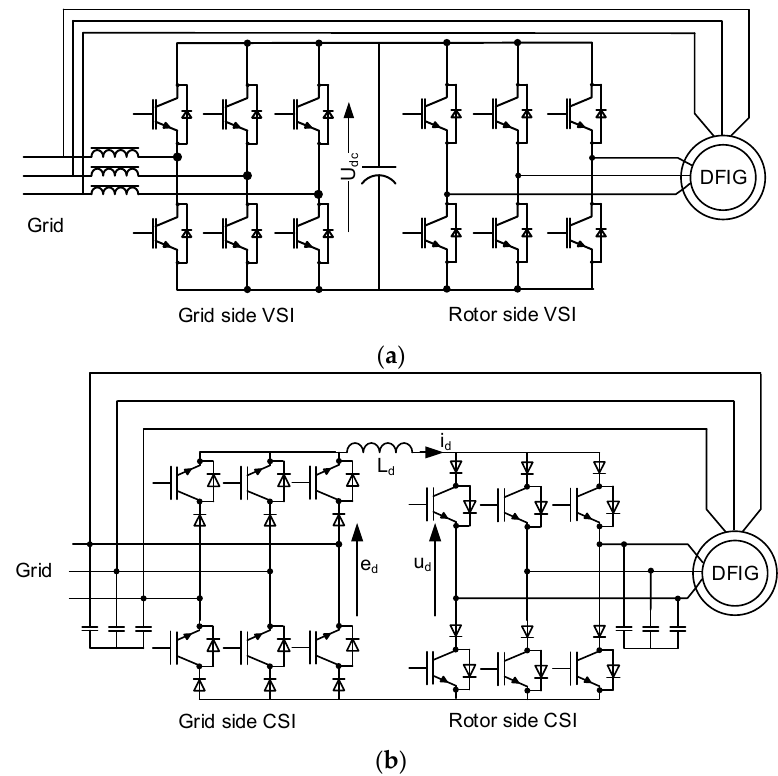
Figure 1. The topology of doubly fed induction generator (DFIG) systems with different constructions of converters at the rotor side: buck-to-buck voltage source converter ( a ) buck-to-buck current source converter ( b ). VSI: voltage source inverter, CSI: current source inverter.